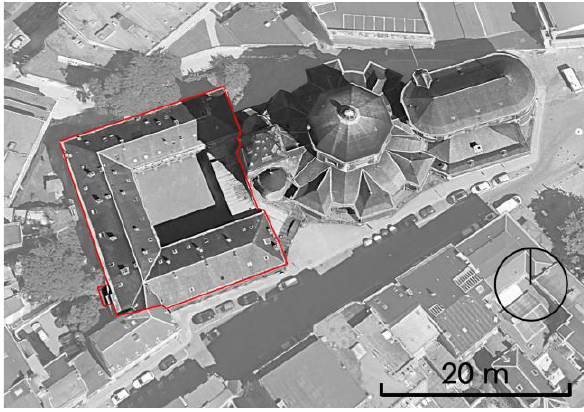
Figure 7. Top view of Saint-Jean Collegiate Church (dark grey) and cloister (highlighted in red). Based on a picture extracted from Google Earth Pro, 2022.